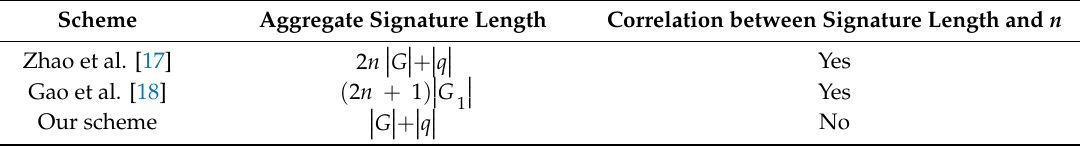
Figure 6. The signature length of schemes based on blockchain. 8. Conclusions